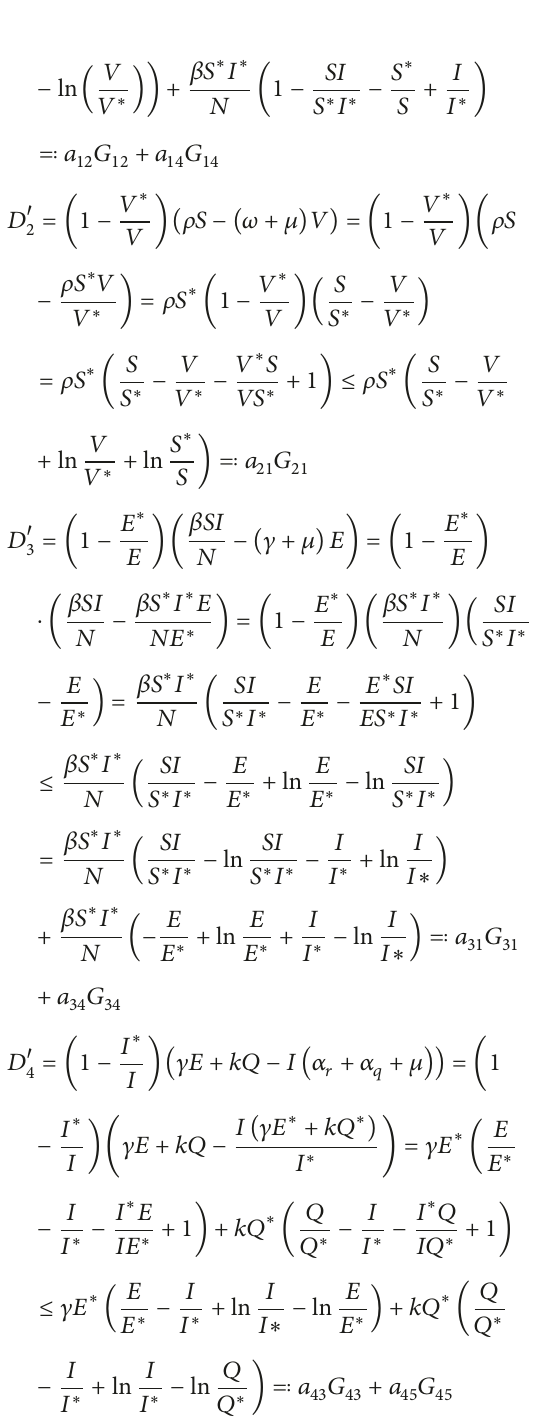
Figure 2: The weighted digraph (𝐺,𝐴) constructed for model